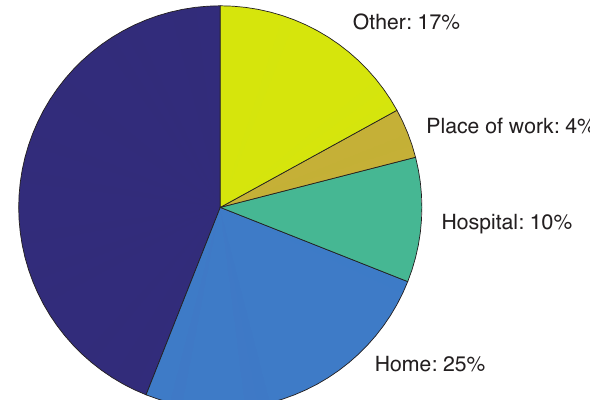
Figure 1. Distribution of COVID-19 cases in Italy as of April 2020, according to the Italian National Institute of Health